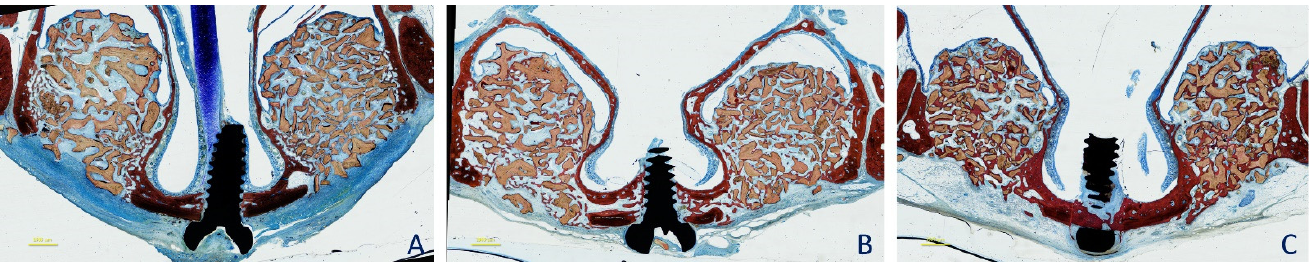
Figure 4. Ground sections representing the augmented sinus at the 0.125–1 mm and 1–2 mm size granules after 2 ( A ), 4 ( B ), and 8 ( C ) weeks of healing. Images originally taken with objective ×10. Stevenel’s blue and alizarin red stain.